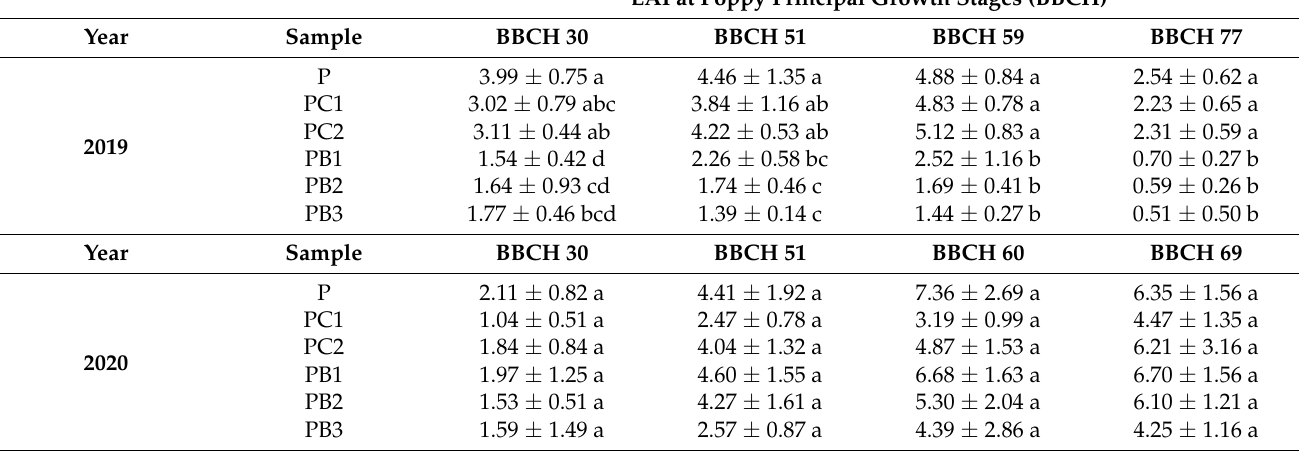
Table 6. Leaf area indices of poppy as sole crop (P) and intercropped with clover (PC1, PC2) and barley (PB1, PB2, PB3) at different BBCH growth stages at Campus Klein-Altendorf 2019 and 2020. Lower case letters indicate significant differences between crop treatments for each growth stage in each year (ANOVA & Tukey HSD test, p <